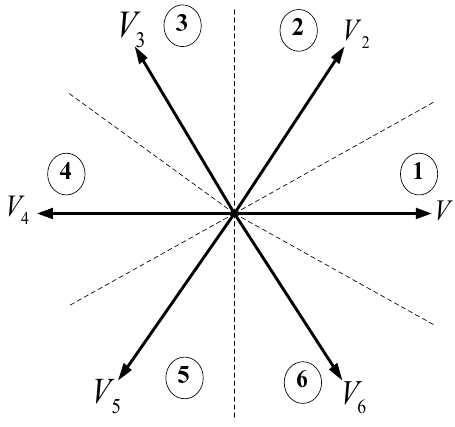
Figure 8. Six vector sectors of a three-phase voltage source inverter.